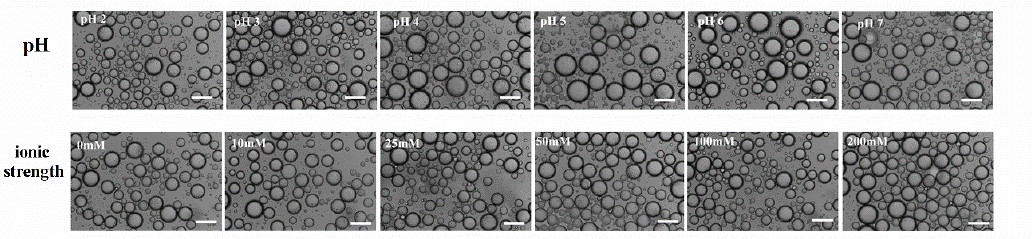
Figure 6. Microstructure of WPI fibrils-stabilized emulsions under different pH values (pH 2.0–7.0) and different ionic strength (0–200 mM NaCl). The scale bar was 100 μ